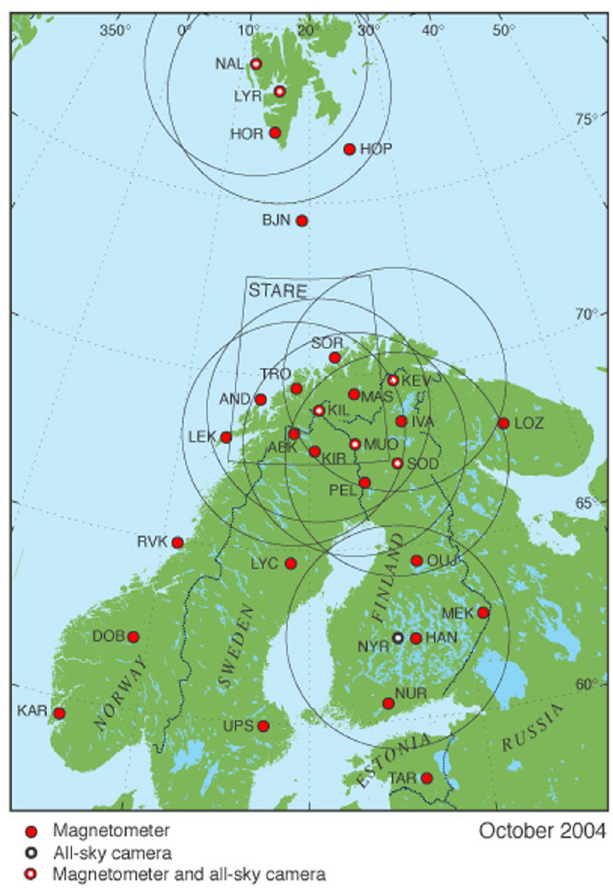
Fig. 1. The MIRACLE instrument network. Circles give the field of view of each all-sky camera. Also the combined field of view of the STARE radars (decommissioned in May 2005) is